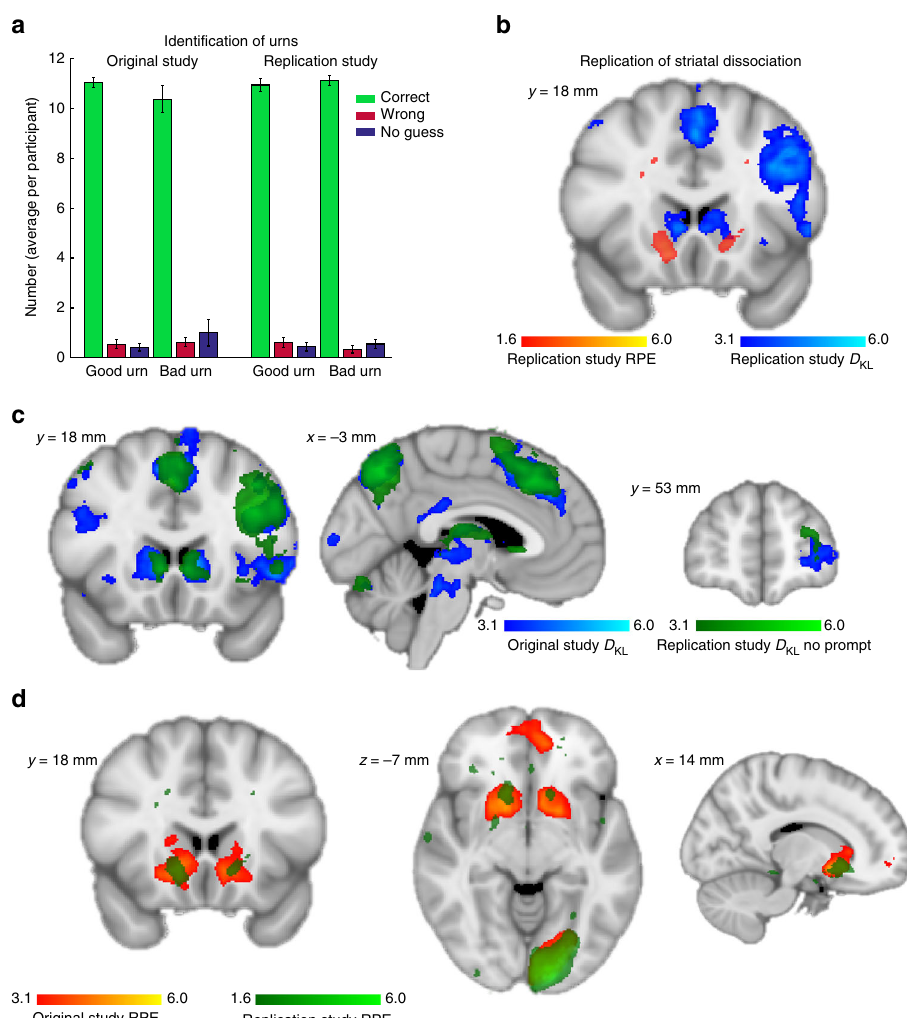
Fig. 7 Results of the replication study. We replicated the main results of the study in a second sample of 18 participants. In this version of the task, participants knew beforehand that they would be prompted about their beliefs only every third trial. In addition, the belief marker was always reset to the indifference point, forcing them to always memorise their beliefs. Participants validly identi fi ed if urns were good or bad in the long-term a . We replicated the striatal dissociation ( b , blue = D KL , red = RPE), as well as all D KL main effects ( c , original = blue, replication = green) even on trials where participants knew they would not be prompted about their beliefs afterwards. This minimises the possibility that D KL effects are related to downstream decision making about how to move the prompt cursor rather than to belief updating. RPE effects were weaker, but still present at lower thresholds, possibly because the RL model could not be fi t to participants without prompting their beliefs. Colour bars represent z-scores, replication effects are displayed at corrected p < 0.001 for D p < 0.05 for RPE effects, original effects as in Fig. 1. See Supplementary Note 1 and Supplementary Methods KL , and uncorrected